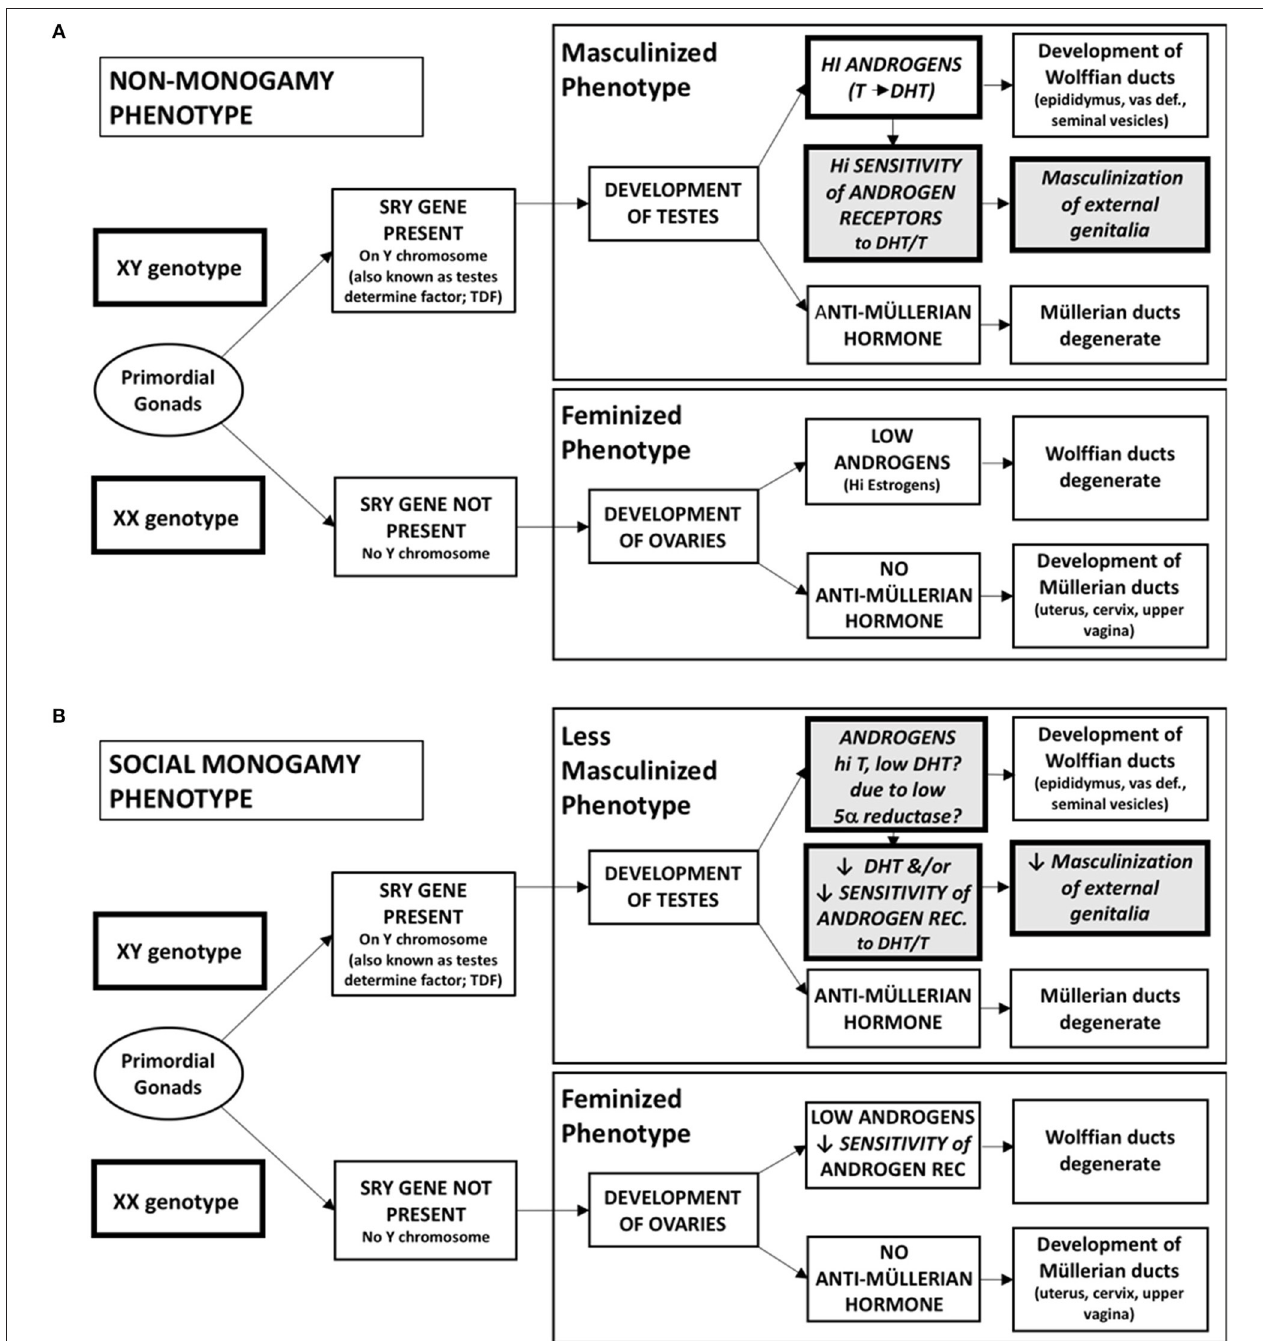
FIGURE 1 | Sexual differentiation into masculinized and feminized physical phenotypes. (A) This classical model characterizes the differential development of the primordial gonad into testes or ovaries, depending on the presence of the SRY gene found on the Y chromosome. As testes develop, high levels of androgens, including testosterone and dihydrotestosterone (DHT), act on highly sensitive androgen receptors to develop masculinized internal (Wolffian duct) and external genitalia. Anti-Müllerian hormone is also produced, causing the Müllerian ducts to degenerate. In the absence of the SRY gene (in an XX genotype), the ovaries produce very low amounts of androgens, causing the Wolffian ducts to degenerate and allowing for feminization of external genitalia. In typical females anti-Müllerian hormone is also not produced, allowing the Müllerian ducts to develop into feminized internal genitalia. (B) In a social monogamy behavioral phenotype, we hypothesize that changes in the response to androgens produced by the testes during prenatal development may lead to changes in the masculinization of the external genitalia in XY genotype individuals. While testosterone production remains high to allow for the masculinization of the internal genitalia, decreases either in the production of DHT or in the sensitivity of the androgen receptor to either testosterone or DHT decrease the extent of masculinization of the external genitalia, a common physical feature of males of socially monogamous species.